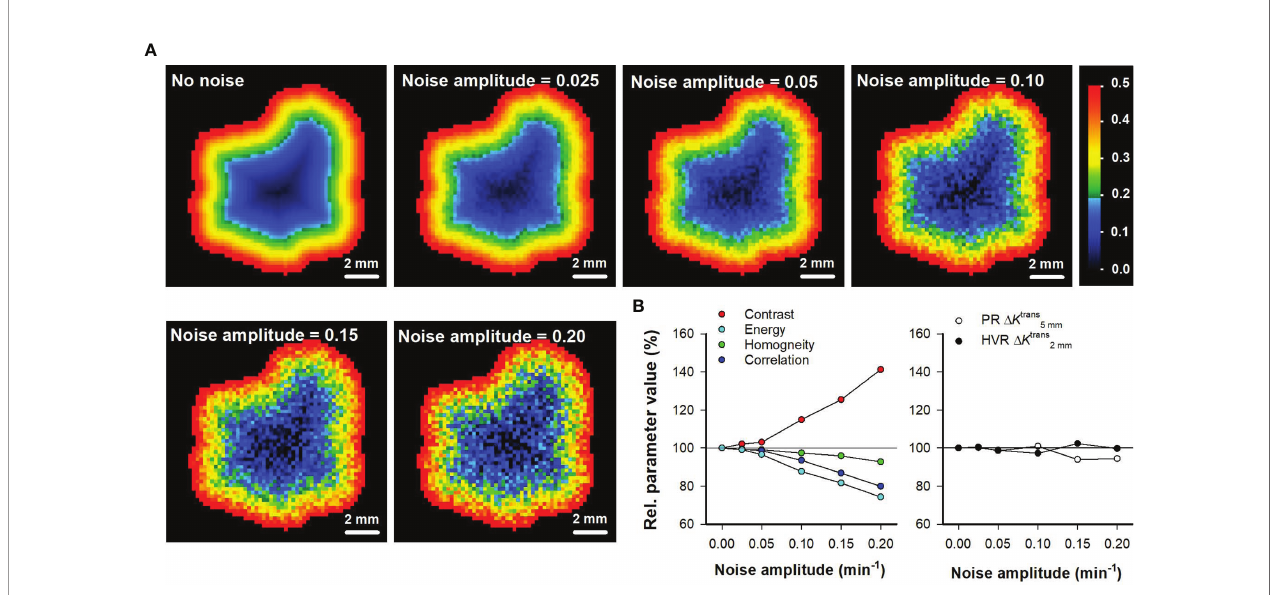
FIGURE 6 | (A) K trans maps of the representative untreated BxPC-3 tumor shown in Figure 1 when the tumor voxels have been rearranged in a perfectly radial geometry without added noise, and with random noise added. The random noise was created by using increasing noise amplitudes as indicated in the maps. The K trans scale is given by the color bar. (B) Relative parameter values of the Haralick features Contrast, Energy, Homogeneity, and Correlation versus noise amplitude, and relative parameter values of the intratumor heterogeneity parameters PR D K trans 5 mm and HVR D K trans 2 mm versus noise amplitude. The relative parameter values refer to % of the parameter value in the map without added noise. Solid horizontal lines indicate 100% (no